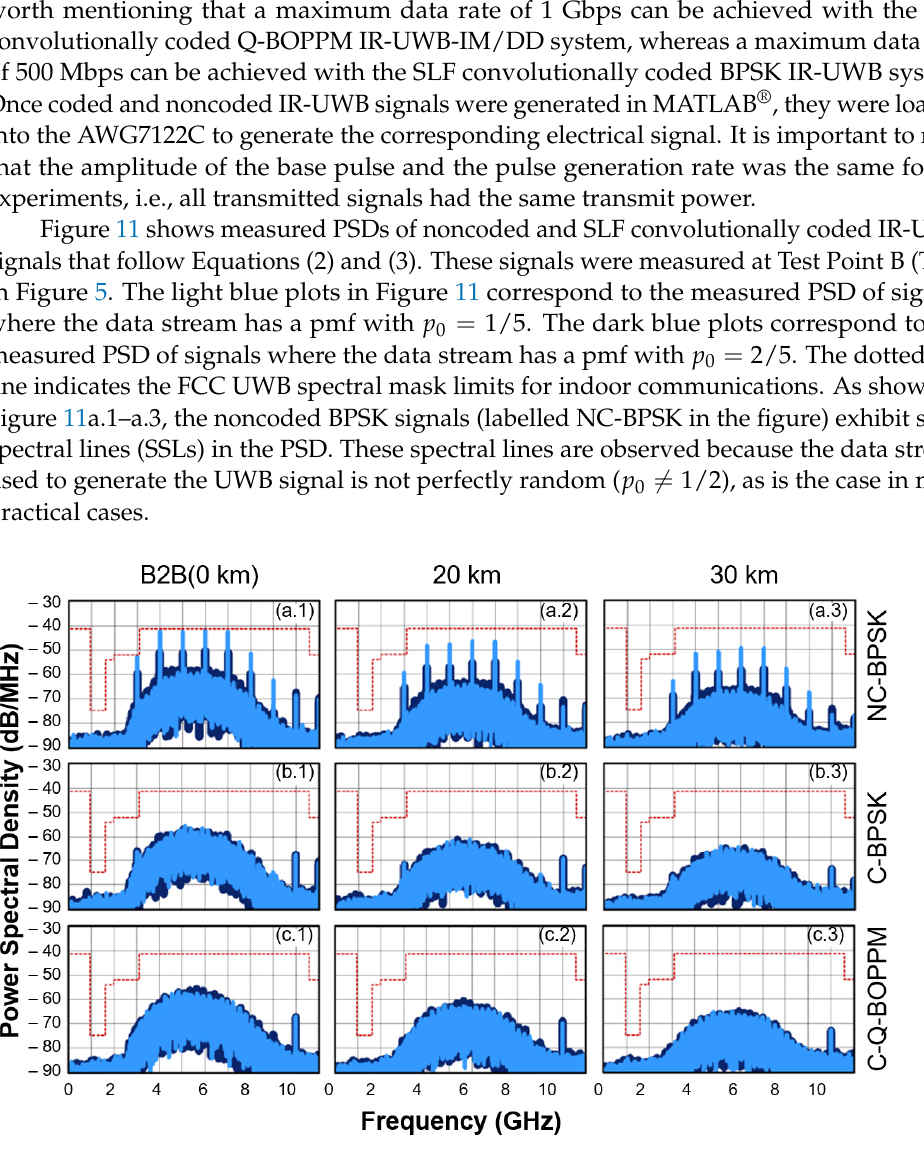
Figure 11. Measured PSDs of signals generated by: ( a ) the noncoded -BPSK IR-UWBoF-EIM/DD system (first row labelled as NC-BPSK—plots a.1 , a.2 , and a.3 ); ( b ) the SLF convolutionally coded BPSK IR-UWBoF-EIM/DD system (second row labelled as C-BPSK—plots b.1 , b.2 , and b.3 ); and ( c ) the SLF convolutionally coded Q-BOPPM IR-UWBoF-EIM/DD system (third row labelled as C-Q-BOPPM—plots c.1 , c.2 , and c.3 ). The PSDs were obtained at Test Point B, pointed out in Figure 5, after 0 km (first column—plots a.1 , b.1 , and c.1 ), 20 km (second column—plots a.2 , b.2 , and c.2 ) and 30 km (third column—plots a.3 , b.3 , and c.3 ) of SMF.